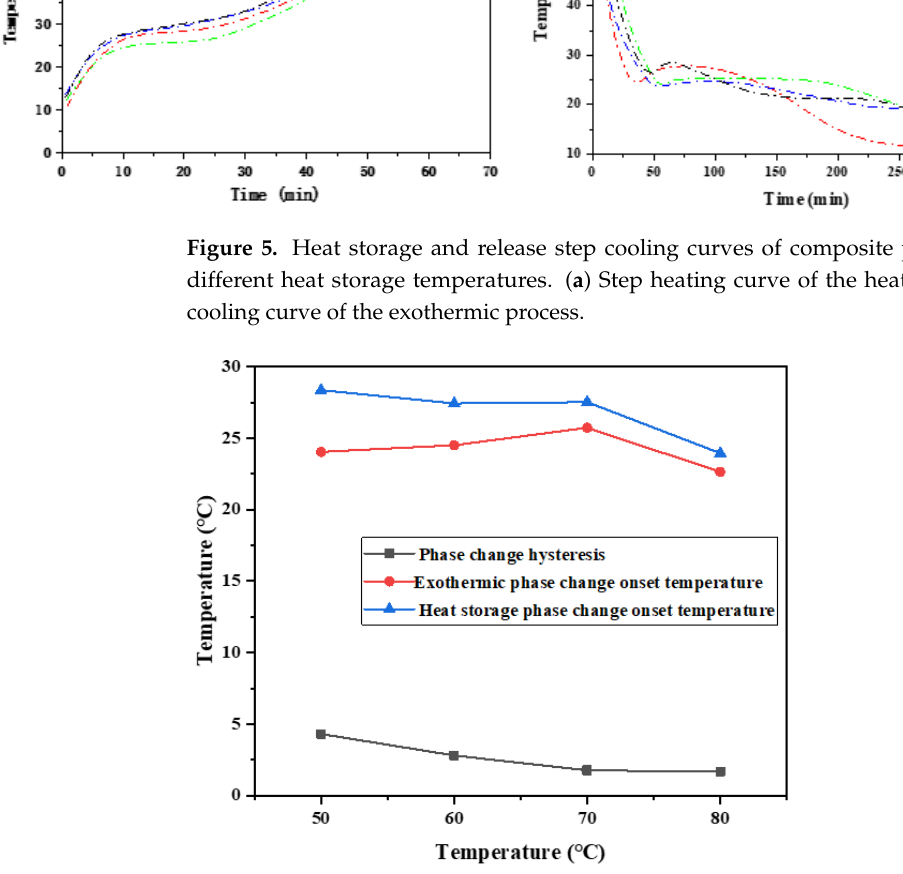
Figure 5. Heat storage and release step cooling curves of composite phase change materials at dif- ferent heat storage temperatures. ( a ) Step heating curve of the heat storage process. ( b ) Step cooling curve of the exothermic process.